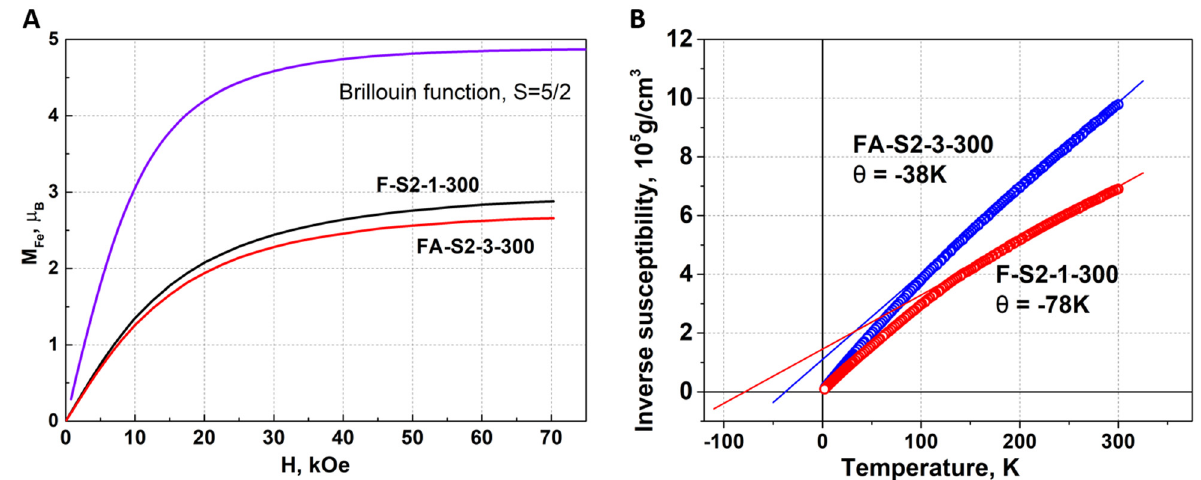
Figure 8. ( A ): Magnetization curves for samples synthesized by the second route: 1- F-S2-1-300, 2- FA-S2-3-300 (X-ray amorphous state). ( B ): Temperature dependence of the inverse susceptibility for samples FA-S2-3-300 and F-S2-1-300. H = 1 kOe. Extrapolation was done from the high-temperature region (150–300 K).